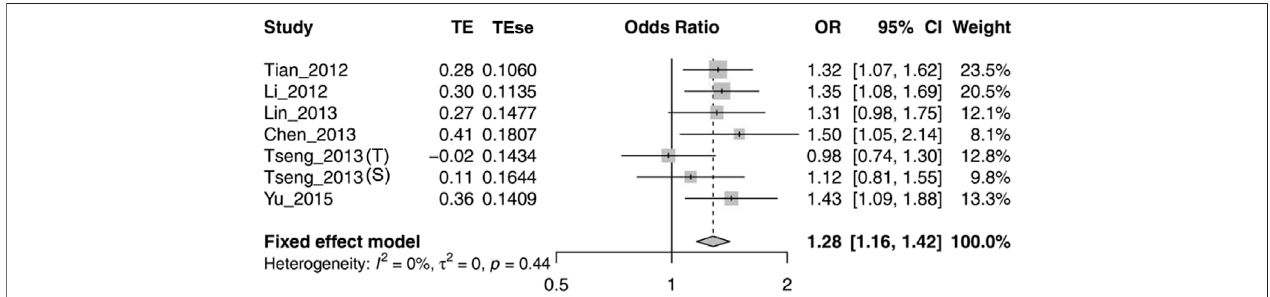
FIGURE2| Forestplotformeta-analysisoftheassociationbetweenrs1564282polymorphismandtheriskofPD.Tseng_2013(T)standsfortheTaiwanpopulation intheTseng_2013study.Tseng_2013(S)representstheSingaporepopulationintheTseng_2013study.TE (cid:1) TreatmentEffect;TEse (cid:1) TreatmentEffectstandarderror; CI (cid:1) Con fi dence Interval.